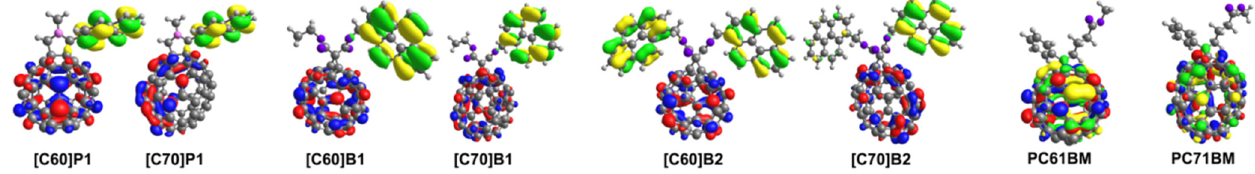
Figure 4. Models of HOMO (green and yellow) and LUMO (red and blue) level orbitals for optimized fullerene derivatives. Yellow and red lobes correspond to positive whereas green and blue lobes to negative isosurface values.